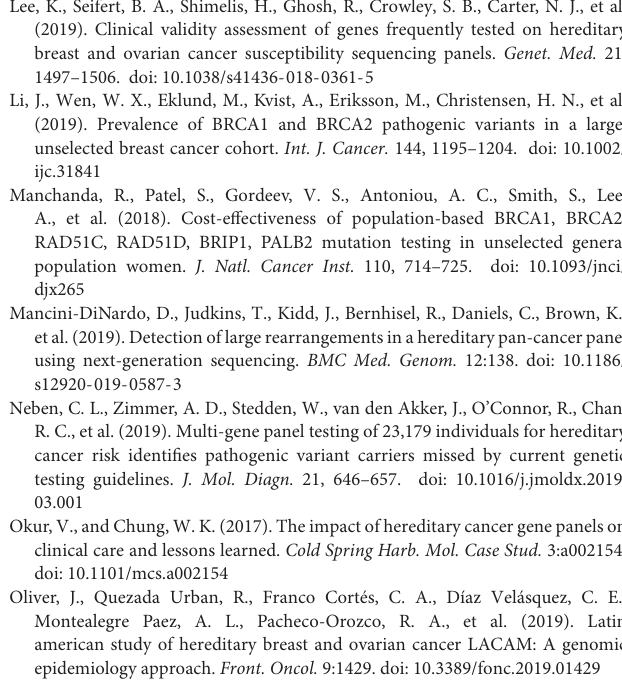
Supplementary Table 1 | Guidelines for referral for hereditary cancer predisposition genetic testing. Supplementary Table 2 | List of genes included in different subpanels and respective